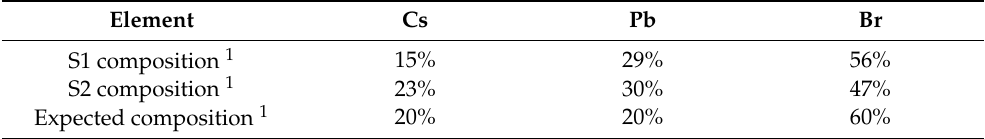
Table 1. Elemental composition of S1 and S2 samples determined from the XPS spectra, and the expected composition of a CsPbBr 3